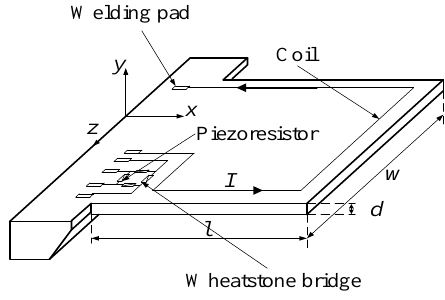
Figure 1. The structure of sensing chip with micro-cantilever.